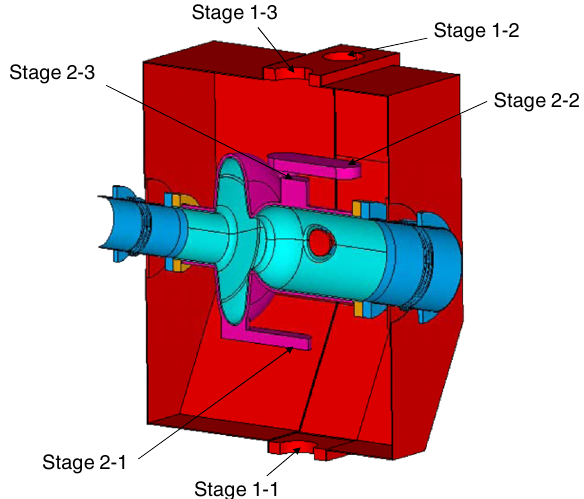
FIG. 10. 3D model used for the thermal analysis. Each color represents a different material: light blue indicates Nb 3 Sn, the dark blue indicates stainless steel, orange represents Ti45Nb, red is the copper first stage intercept, and fuchsia represents the copper plating on niobium. The nomenclature “ Stage 1-3 ” means first stage of cryocooler number 3. The fourth cryocooler is symmetric to cryocooler number